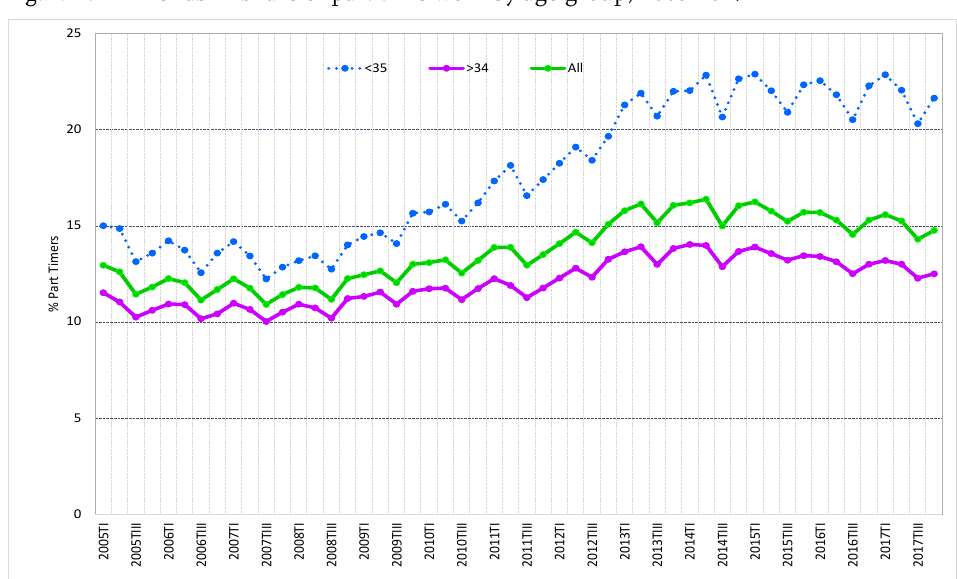
Source: Spanish Labour Force Survey (Encuesta de Población Activa, EPA), 2005-2017. Instituto Nacional de Estadística (INE). Figure 4 : Trends in share of part time work by age group, 2005-2017